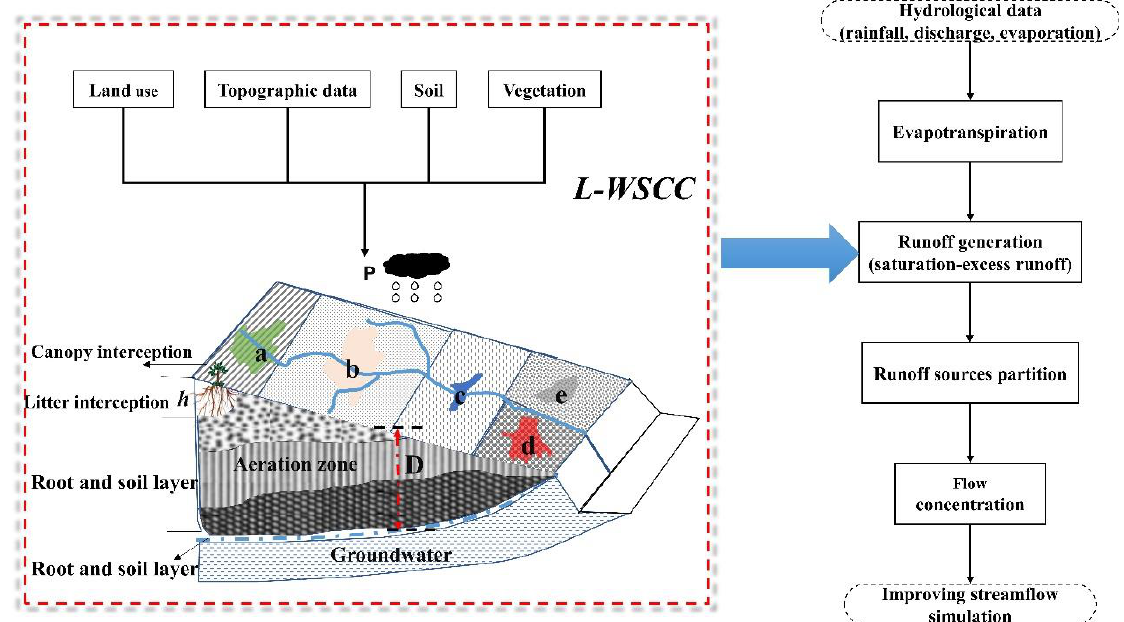
Figure 2. Adopted flowchart of the study and Schematic diagram of different land-use areas and soil layers in the watershed ( a – e represent different land-use areas, h is the depth of litter layer, D is the thickness of aeration zone, and P is rainfall).